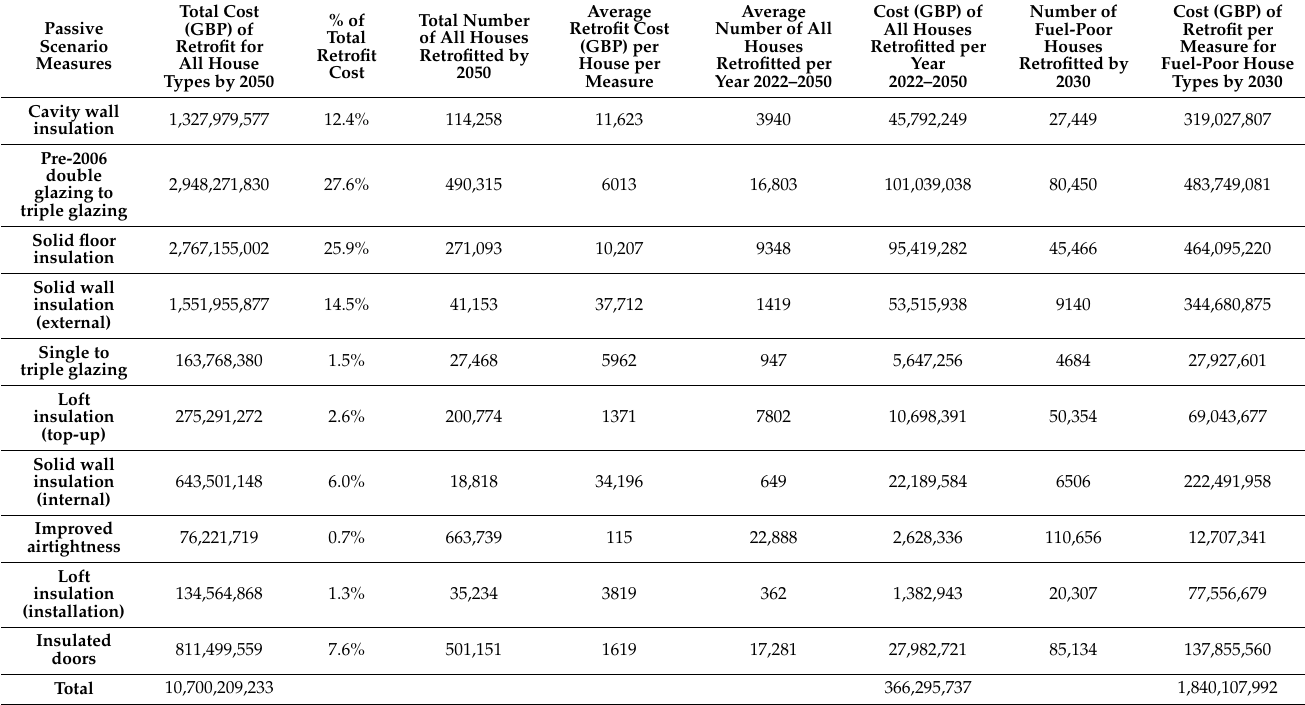
Table 7. Retrofit cost breakdown for the Passive Scenario.